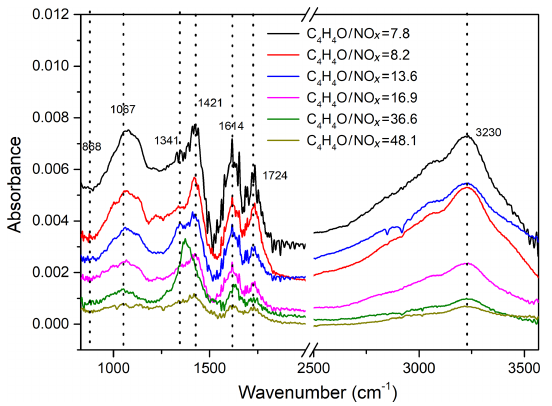
Figure 5. FTIR spectra of particles collected from furan– NO x –NaCl photooxidation experiments with different values of C 4 H 4 O / NO x ratio, ranging from 7.3 to